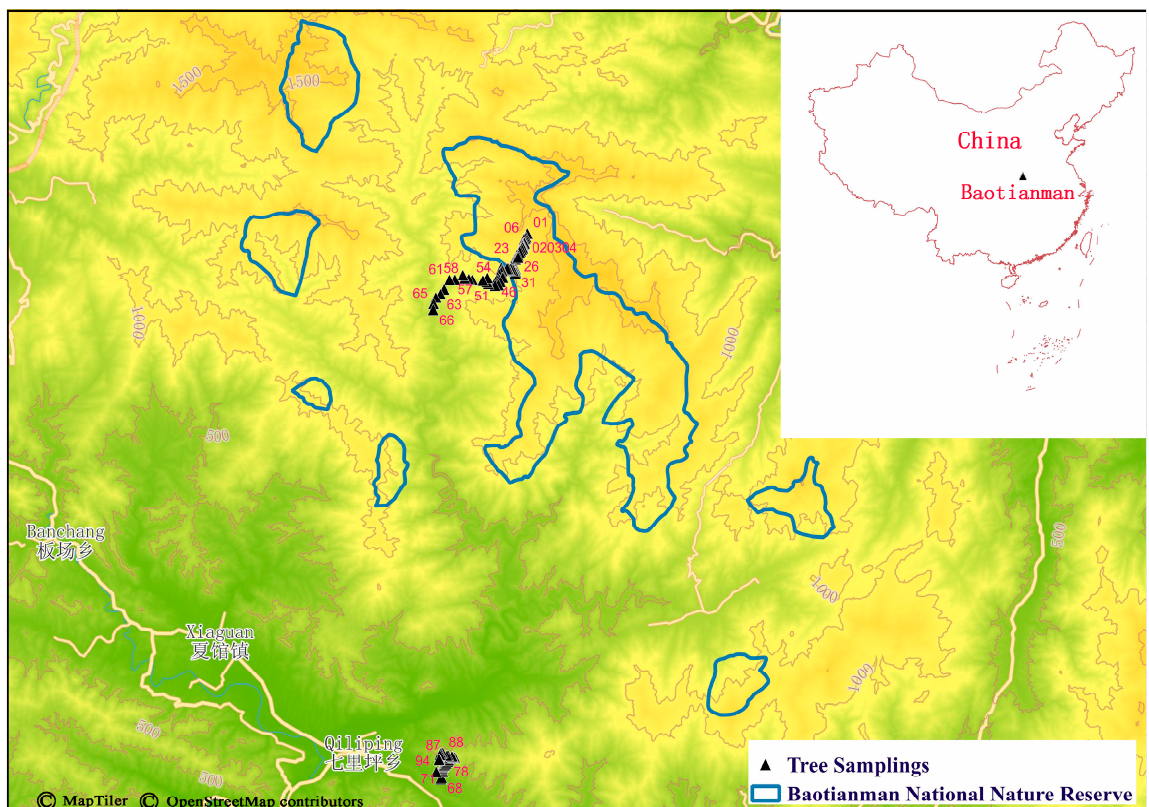
Figure 1. Sampling areas of leaf mines on Quercus variabilis Blume at Baotianman, Henan. The numbers in pink indicate the order of tree samplings. The reserve boundary was provided by Baotianman National Nature Reserve Administrative Bureau. The map was constructed using QGIS 3.26.3 [74]. QGIS MapTiler Plugin can obtain OpenStreetMap data from the OpenMapTiles project (openstreetmap.org). The base maps, terrain, and contours for this plugin are available from